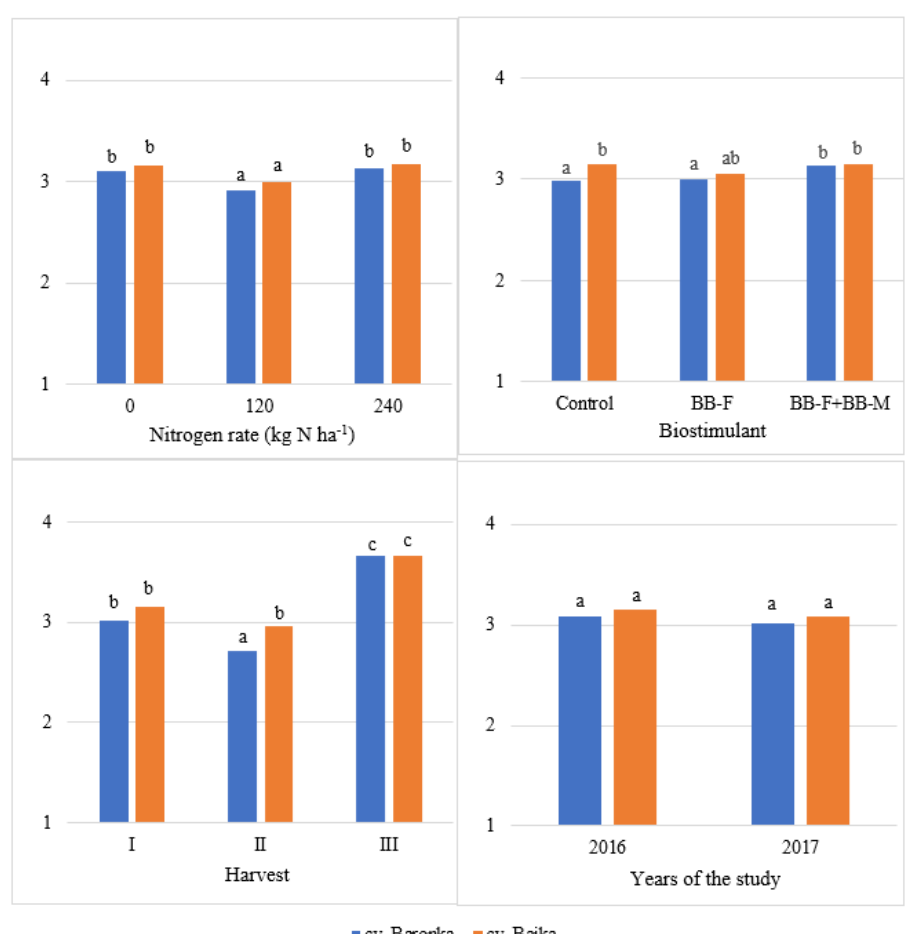
Figure 4. Relationships between the content of phosphorus (g kg − 1 DM) in the post-harvest biomass of the analyzed perennial ryegrass cultivars vs. nitrogen rate, biostimulant and years of the study (the same letter do not differ significantly at p < 0.05 in Tukey’s HSD test). Table 6. Content of potassium in perennial ryegrass biomass (g kg − 1 DM).